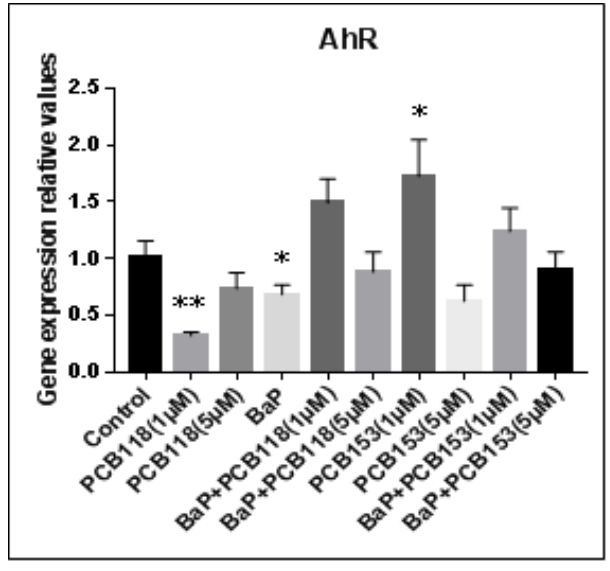
Figure A3. Effects of PCB118, PCB153 and BaP in “Time 1” conditions on the expression of AhR . 3T3-L1 cells were incubated with or without PCB118 (one or five micromolars) or PCB153 (one or five micromolars) in the presence or not of BaP (one micromolar) according to the “Time 1” conditions described in materials and methods. Cells were washed twice with PBS and mRNA extraction and qRT-PCR were performed as described under materials and methods. Each incubation condition was carried out in quadriplicate and the experiment was repeated three times with similar results. The data are mean ± SD. The level of significance is given by comparison of treated trials with controls ( n = 4 per group): * p < 0.05; ** p < 0.01.